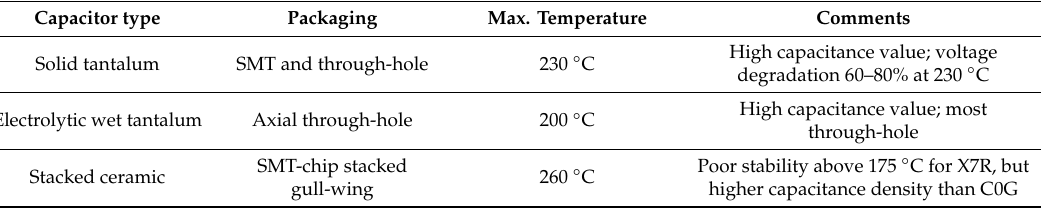
Figure 7. Capacitance stability with temperature and DC link voltage for the XHT stacked ceramic capacitors from Presidio. Table 6. Commercially manufactured capacitors for high-temperature applications